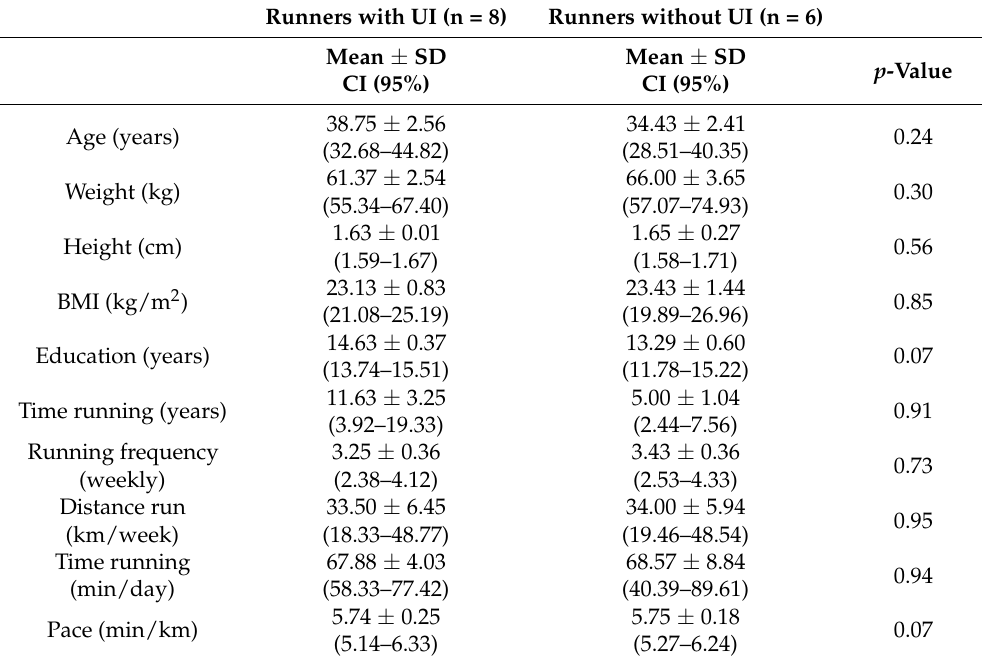
Table 1. Sociodemographic and anthropometric characteristics, as well as the training regimen of women half-marathon runners with and without urinary incontinence (n = 14). Pernambuco, Brazil,